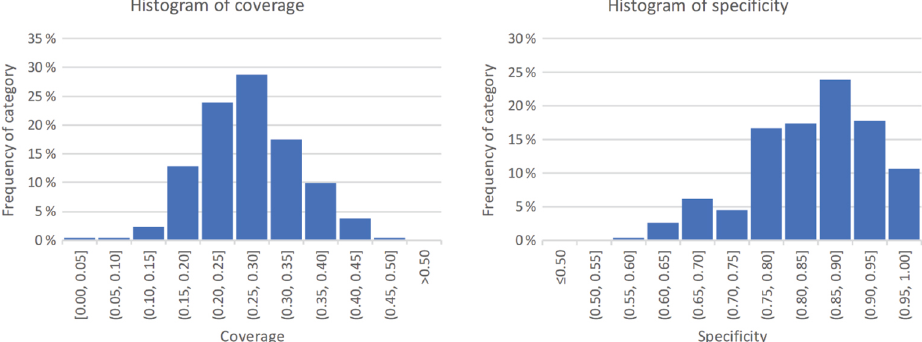
Figure 1: The histograms for the distribution of the two measures of metadata quality in MetaboLights. On the left, the distribution for term coverage; on the right, the distribution for semantic specificity. Data calculated based on the 2017